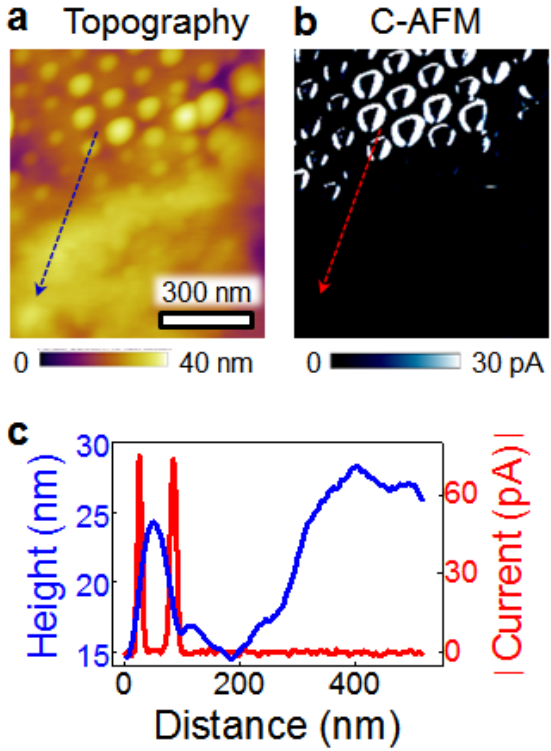
Figure 1. Comparison of topography and current response between BiFeO 3 (BFO) nanodots and unetched film. ( a ) Topography and ( b ) current map (scanned with +1 V) of BFO nanodots and unetched film. In the current map, the nanodots show ring-shaped conduction channels (white color), while the unetched film shows negligible current (black color). ( c ) Height and current profiles along the section lines in a and b, respectively.